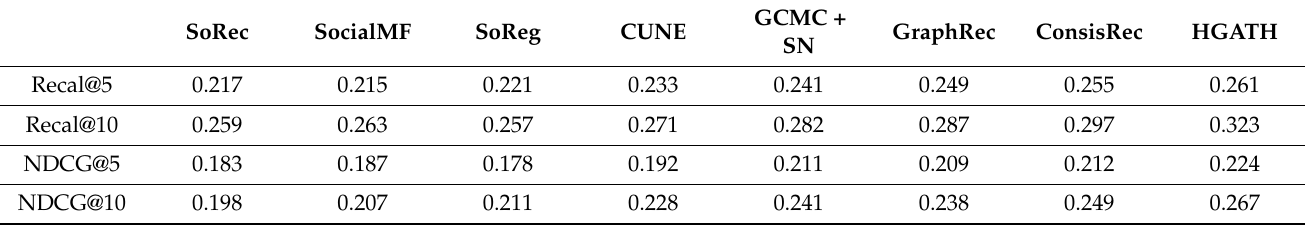
Table 4. Comparisons of different methods on the Epinion